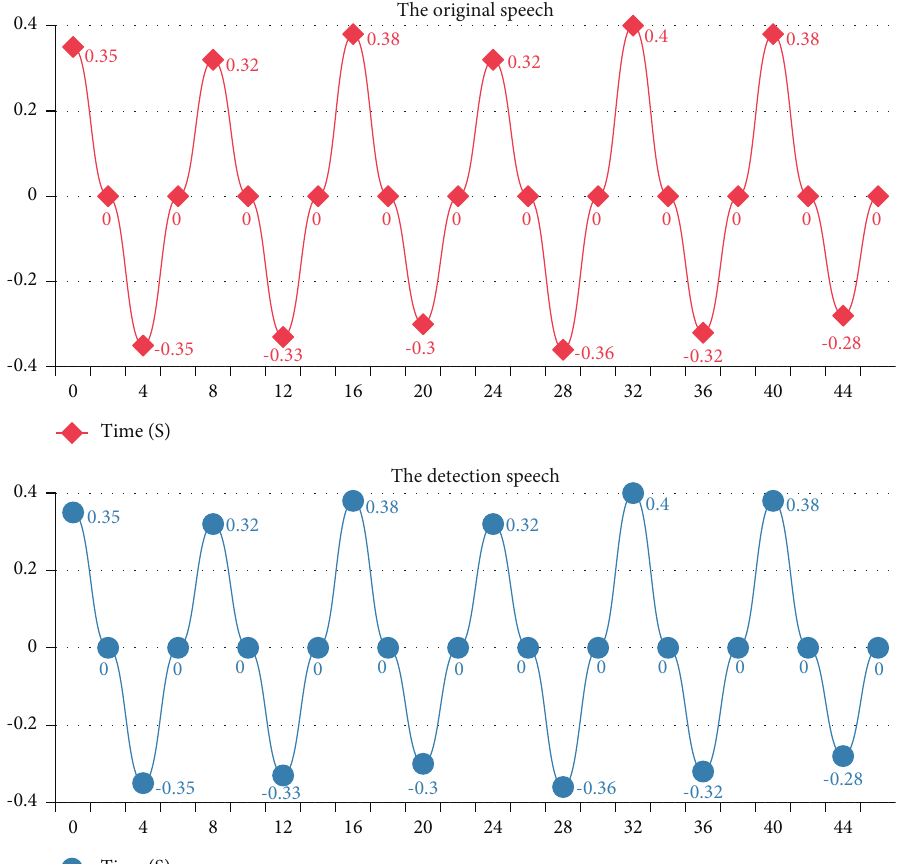
Figure 5: The effect of the improved algorithm in the actual endpoint detection. (a) The original speech. (b) The detection